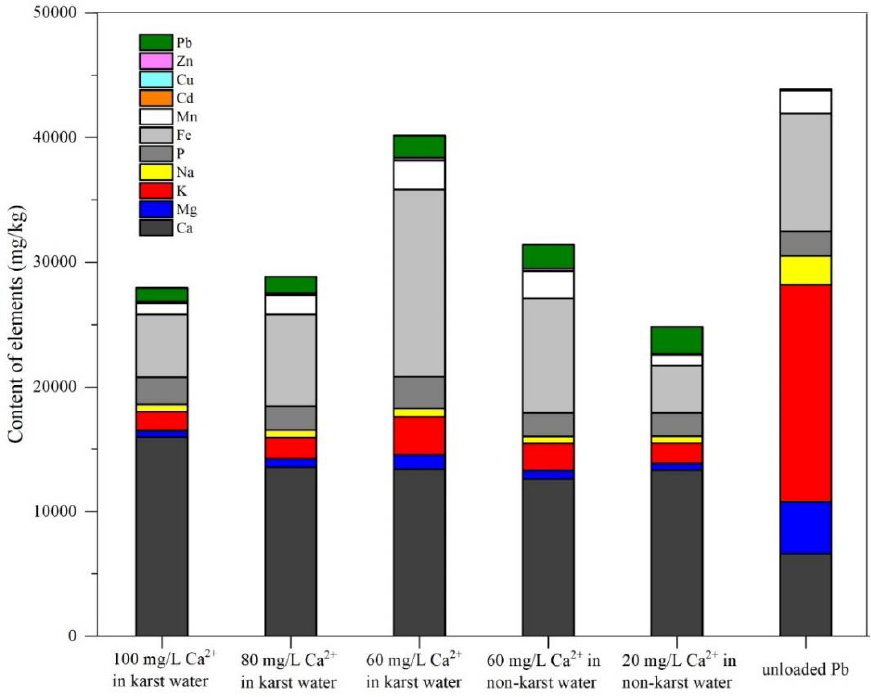
Figure 5. Elemental composition and distribution in E. crassipes roots before and after Pb absorption from water with different Ca 2+ concentrations.